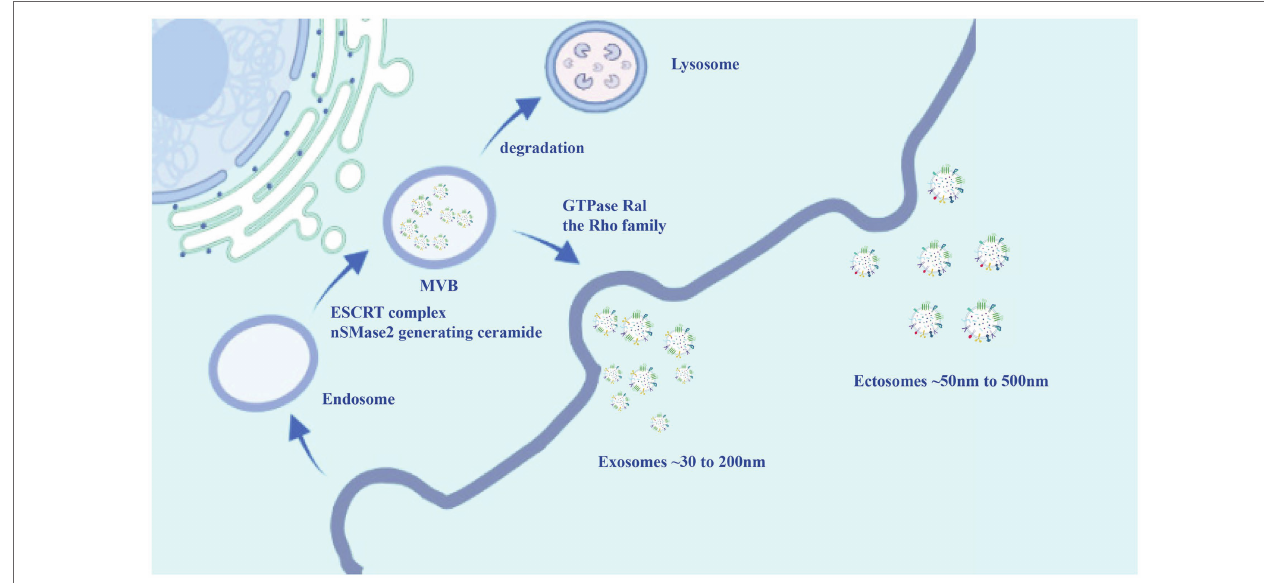
FIGURE 1 | The biogenesis of extracellular vesicles (EVs). Exosomes and ectosomes are two types of EVs secreted by cells. Exosomes (~30–200 nm in diameter) originate from the endosomal pathway and are secreted by the fusion of multivesicular bodies (MVBs) with the plasma membrane. Ectosomes (size range ~50–500 nm) are generated by the direct outward budding of the plasma membrane. The budding of EVs involves a variety of mechanisms, and is a combination of one or more of the following mechanisms: endosomal sorting complexes required for transport (ESCRT) complex, neutral sphingomyelinase 2 (nSMase2) generating ceramide, GTPase Ral, and the Rho family. However, specific biogenesis mechanisms are not yet clearly known. EVs are highly heterogeneous population. The cargos of EVs contain different types of cell surface proteins, intracellular protein, genetic materials [such as DNAs, messenger RNAs (mRNAs), and miRNAs], and